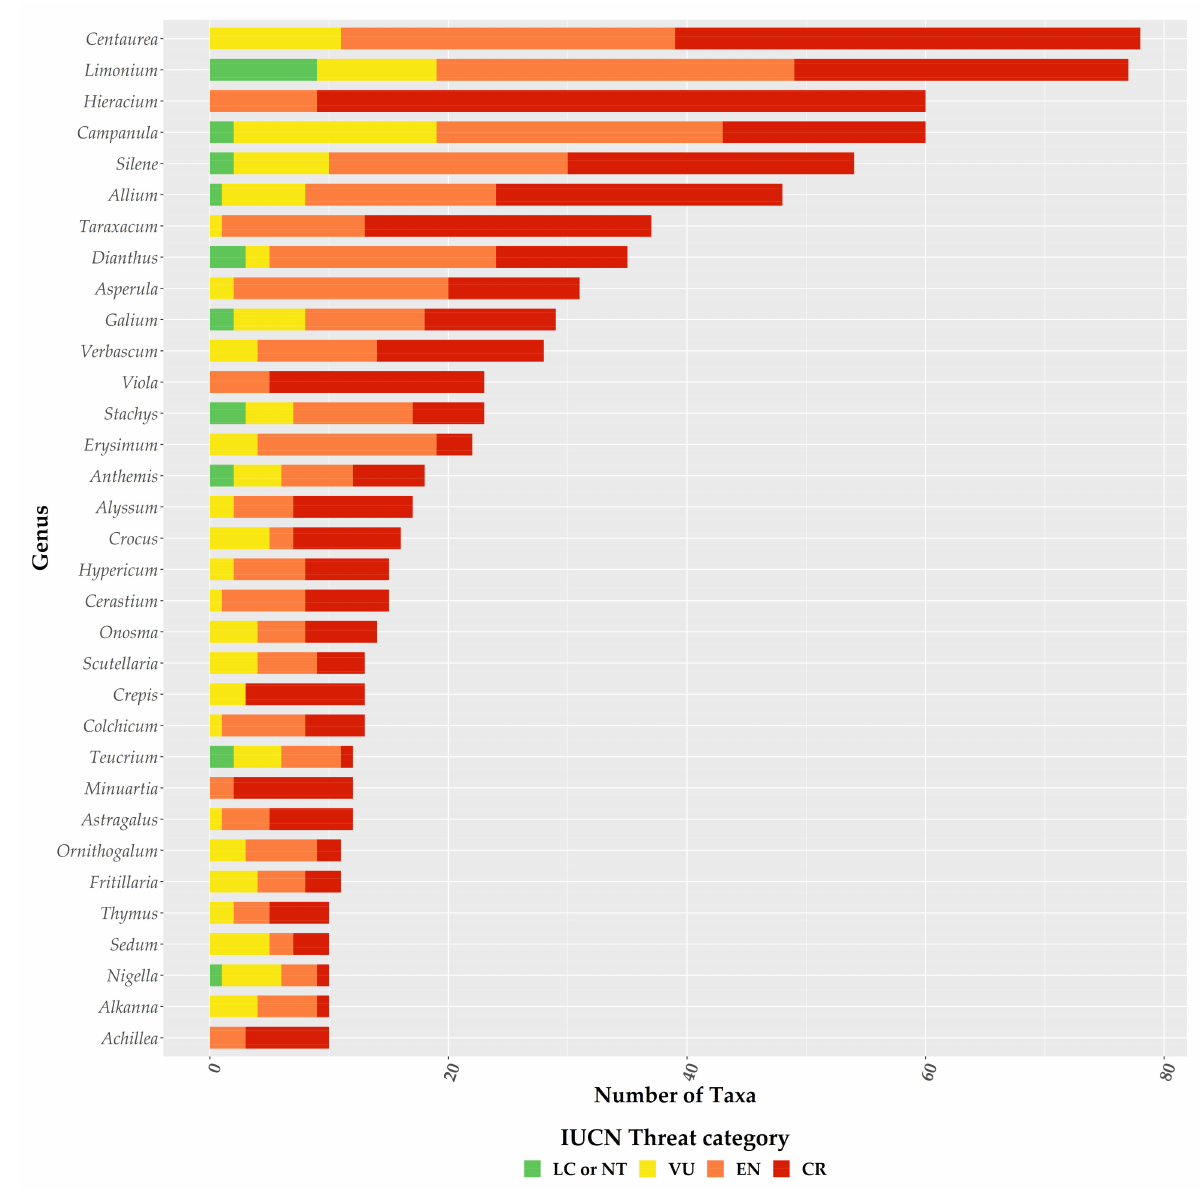
Figure 5. Proportion of the Greek endemic taxa under the IUCN threat categories according to both Criterion A and B for the richest plant genera. Please note that information is presented only for genera with 10 or more Greek endemic